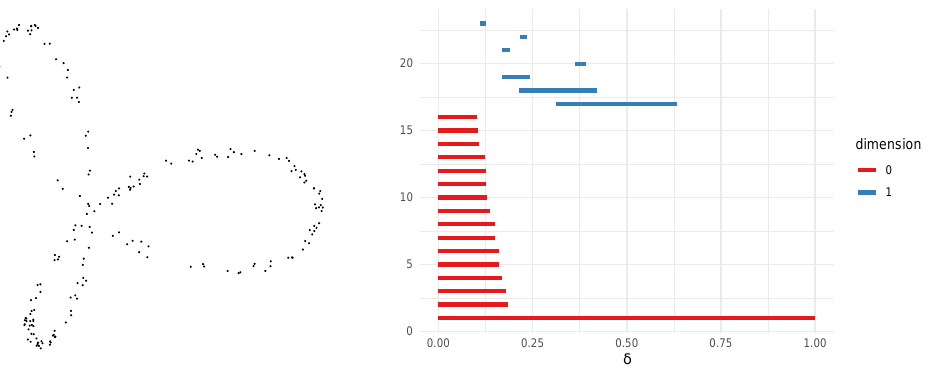
Figure 5. A dataset scattered around the wedge sum of three circles and its barcode for 0.15 ≤ δ ≤ 1. The three longest lines in dimension 1 correspond to the three circles in the dataset. The longest line in dimension 1 shows that the biggest hole in X δ exists for 0.31 ≤ δ ≤